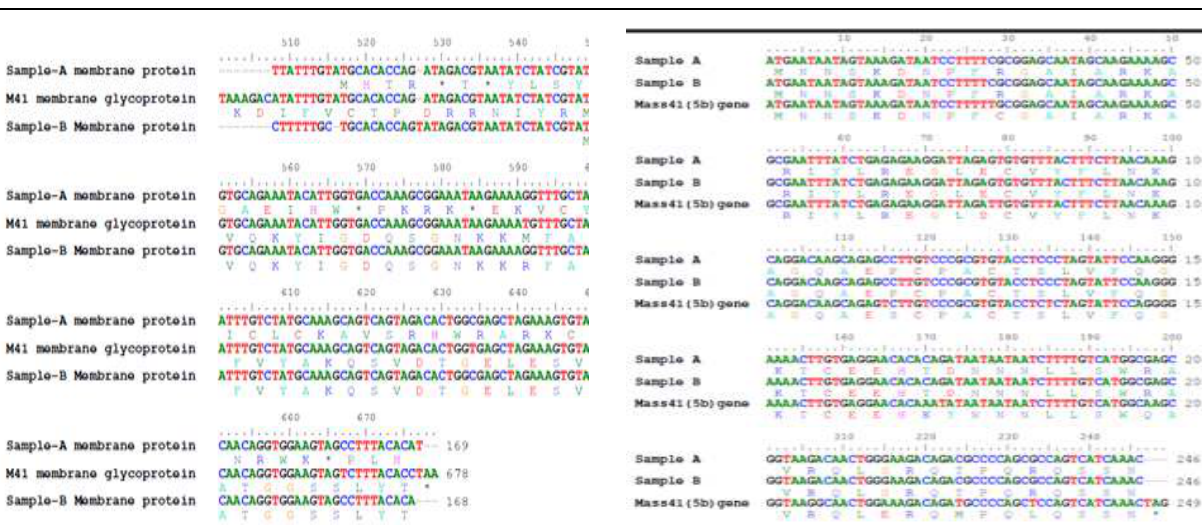
Figure-4. Multiple sequence alignment of both nucleotides and amino acids (in single letter code) for a total of 169 bp of M gene of isolates Ind/KA/07/1 (Sample A) and Ind/TN/07/2 (Sample B) along with that of M 41 strain.